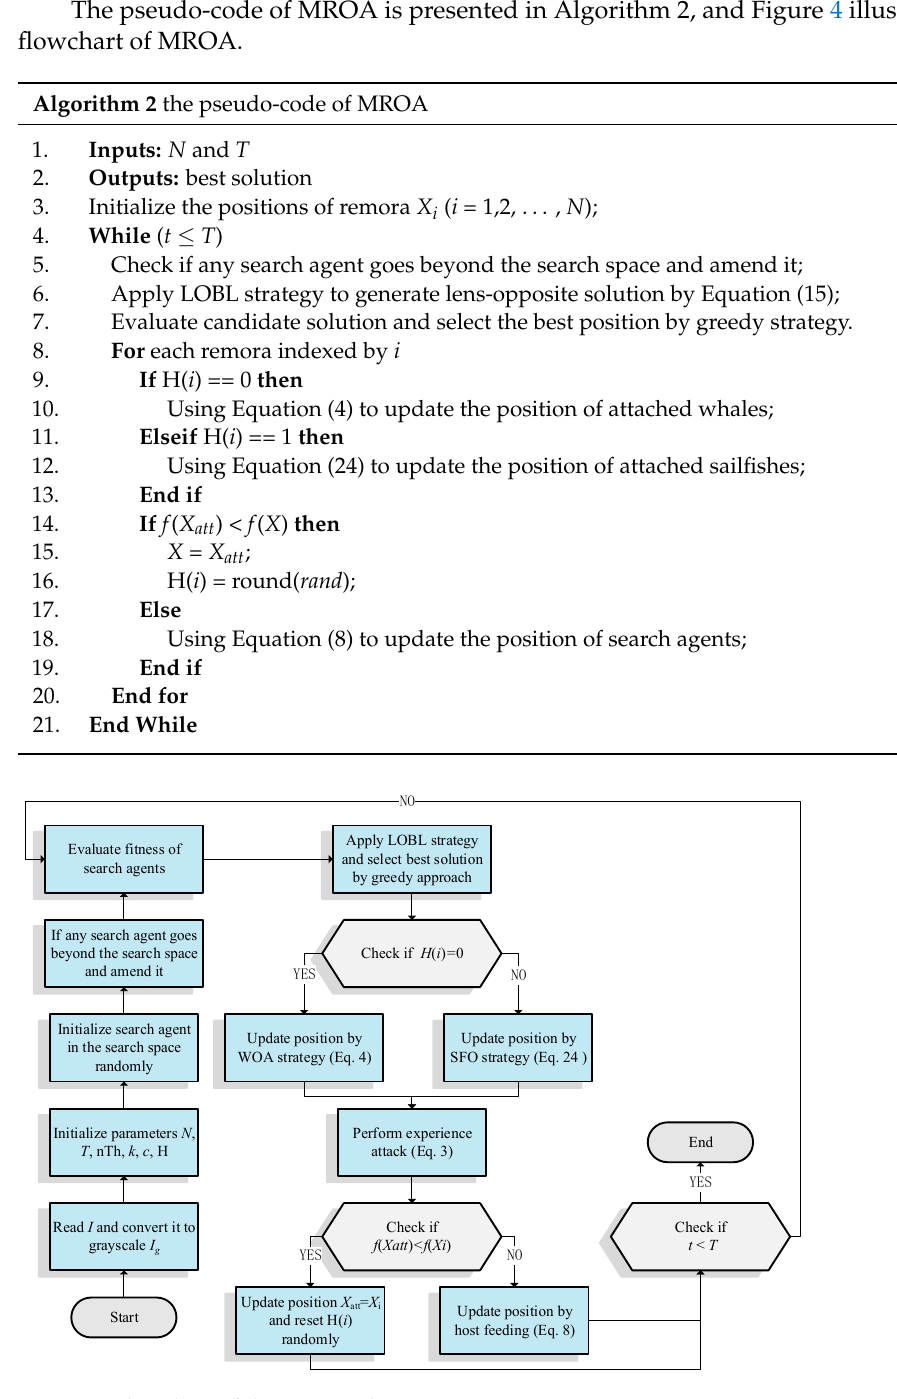
Figure 4. Flowchart of the proposed MROA. Algorithm 2 the pseudo-code of